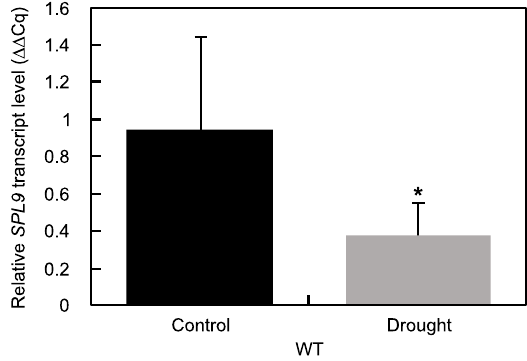
Figure 2. MsSPL9 transcript abundance in well-watered control and drought-treated WT alfalfa: the asterisk indicates significant differences between conditions ( p < 0.05, where n = 9, 10, Student’s t -test).